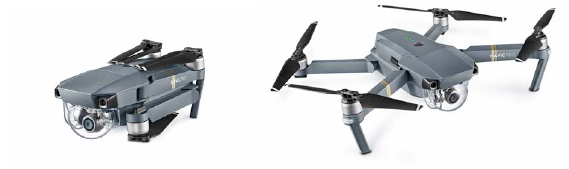
Figure 3. DJI Mavic Pro. Source: www.dji.com